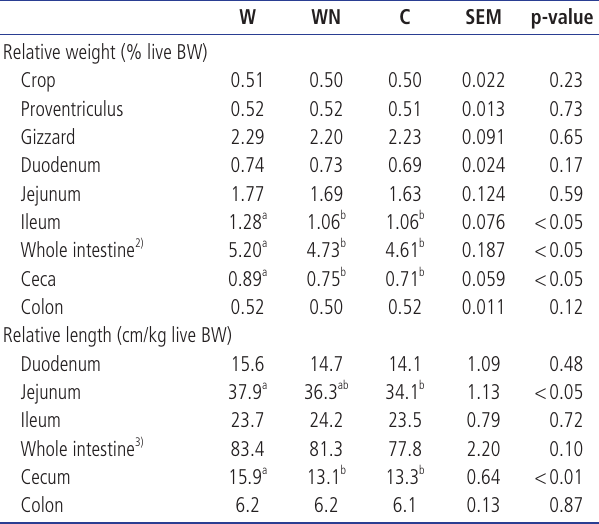
Table 4. Effect of Natuzyme Plus 1) inclusion in wheat-based diet on the relative weight of empty digestive tract and the relative length of intestine and cecum in broiler chickens W WN C SEM p-value Relative weight (% live BW)